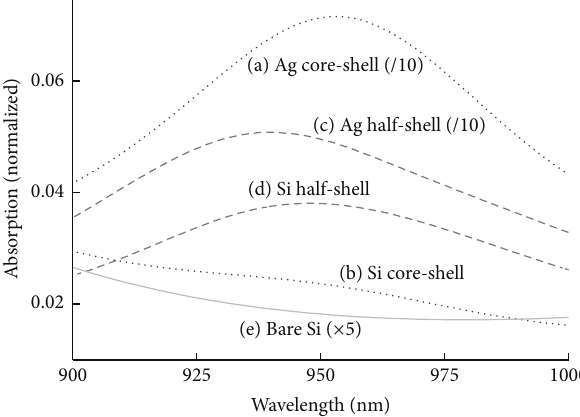
Figure 3: Power absorption spectra in silver (traces (a) and (c)) and silicon (traces (b) and (d)) for the core-shell and half-shell nanowires. Absorption in bare silicon without nanowire is shown in (trace (e)). This trace was scaled up by 5 times, and absorption in silverwasdownscaledby10times.Powerabsorptionwasnormalized with respect to source